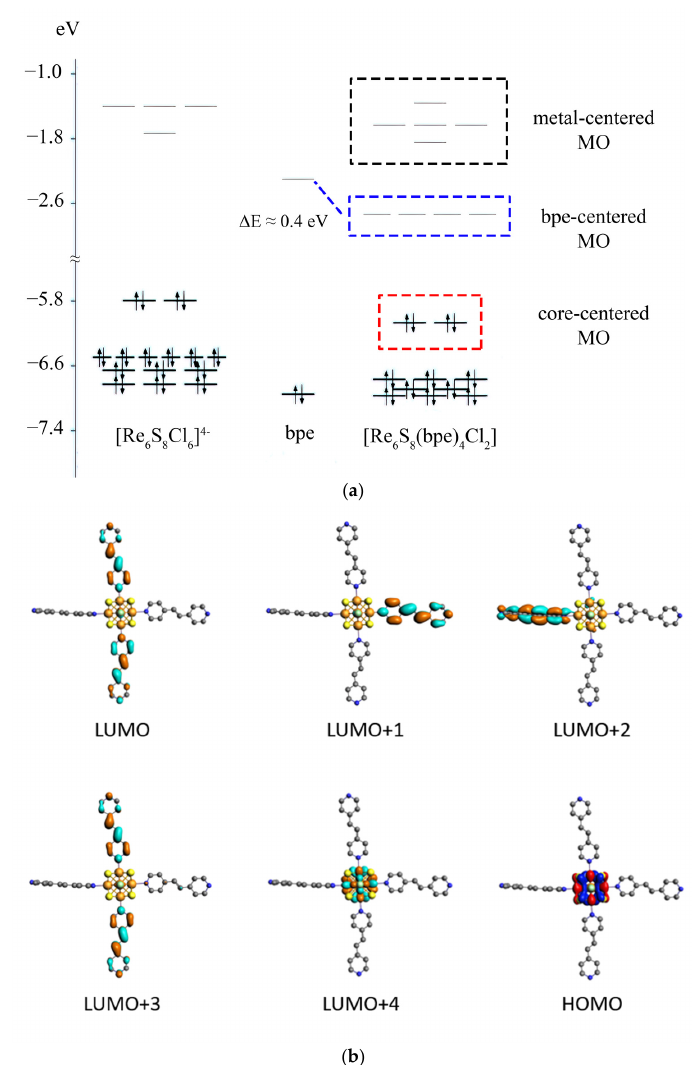
Figure 7. Energy levels diagram for the [Re 6 S 8 (bpe) 4 Cl 2 ] cluster complex in comparison with energy levels of [Re 6 S 8 Cl 6 ] 4– cluster anion and bpe molecule ( a ); molecular orbitals of the [Re 6 S 8 (bpe) 4 Cl 2 ] cluster anion in near frontier region ( b ). Isosurface isovalue is 0.03 a.u.